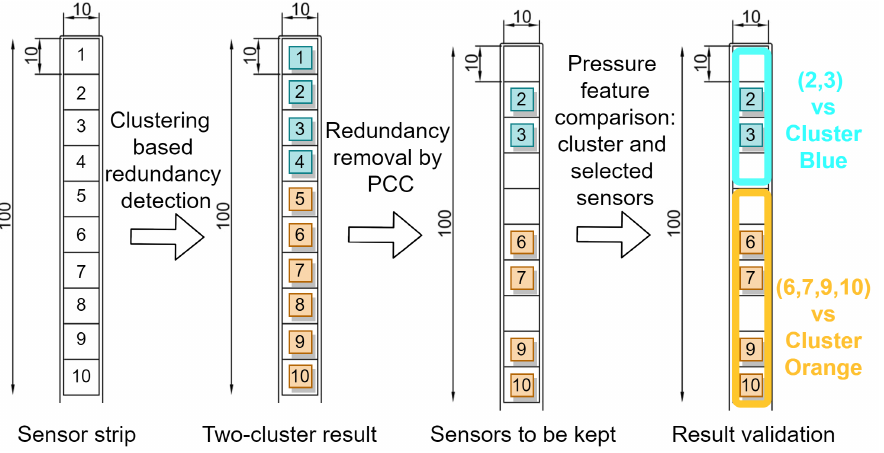
Figure 4. An example of a redundancy removal procedure on a sensor strip consisting of 10